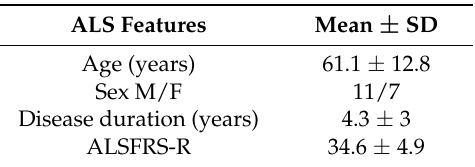
Table 1. Clinical characteristics of the ALS patients at baseline.